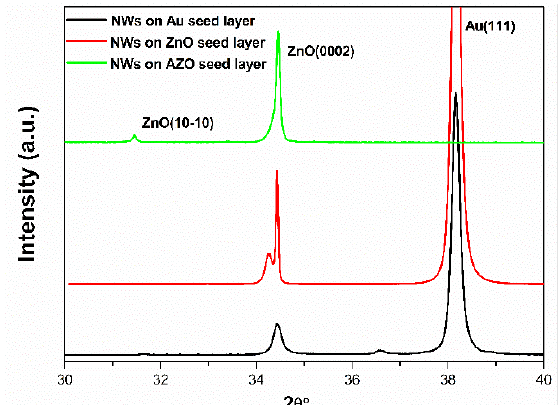
Figure 5. XRD patterns of the ZnO NWs grown on Au, ZnO and AZO seed layers before the parylene C coating step.